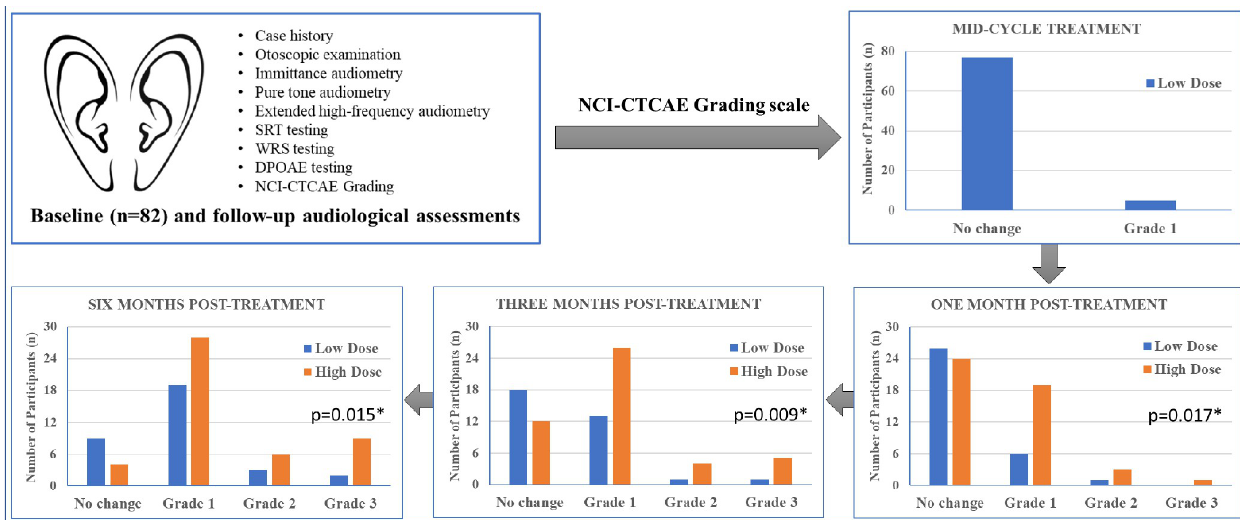
Fig 4. Temporal variation in severity of ototoxicity according to NCI-CTCAE classification. * denotes statistical significance in the relationship between Cisplatin dose and Grade (Fisher’s exact test) At mid-cycle, all patients received 3 cycles of cisplatin (150 mg/m 2 )–stratified as Low Dose only.